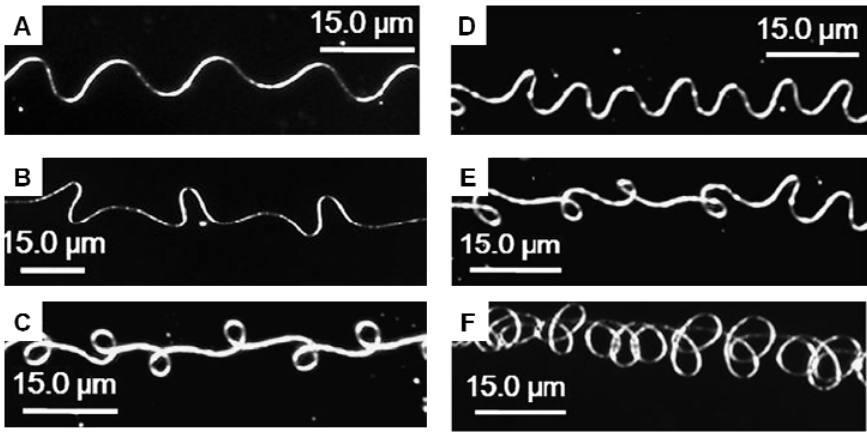
Figure 7. Buckled patterns created from electrified jets of polyethylene oxide collected on glass slides (Reprinted with permission from Han et al. [138]. Copyright 2007